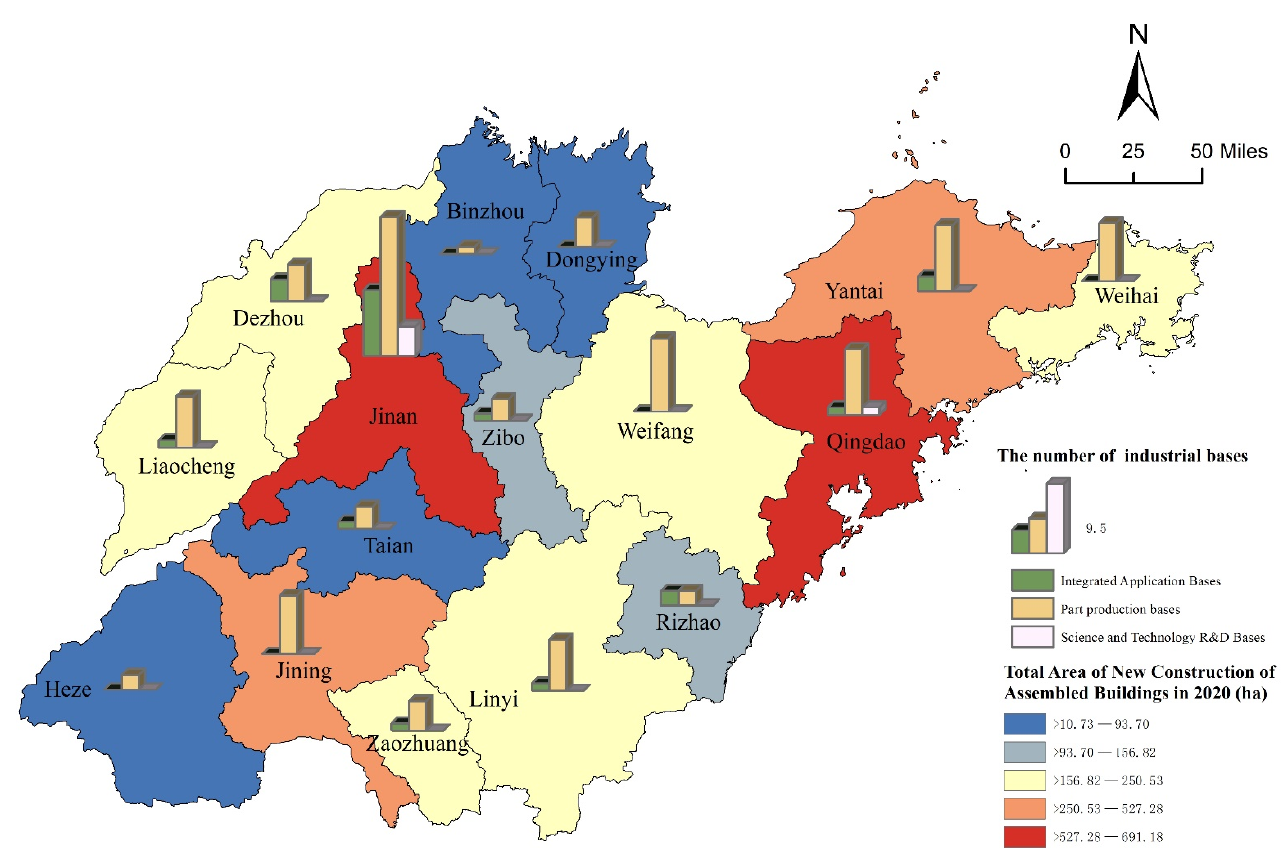
Figure 4. Distribution of new assembly floor space and bases in Shandong Province.